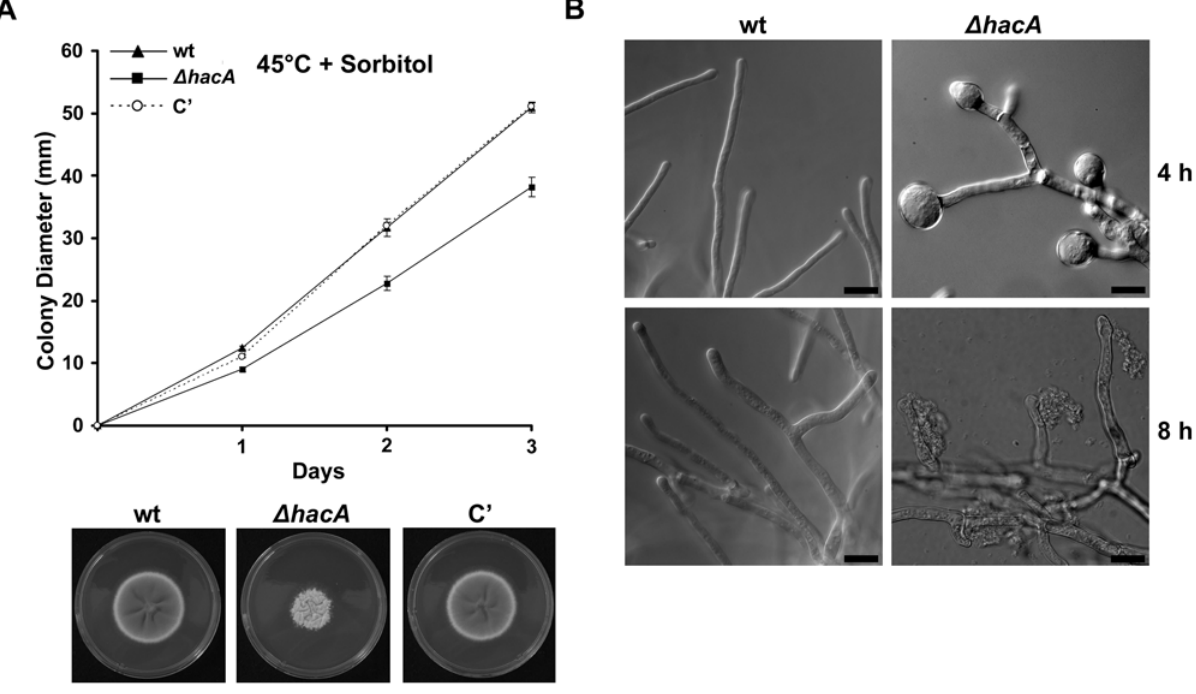
Figure 6. The UPR contributes to cell wall integrity at 45 u C. (A) The temperature-sensitivity of D hacA is remediated by sorbitol: Conidia were inoculated onto the center of an IMA plate containing 1.2 M sorbitol and incubated at 45 u C for 3 days. The experiment was performed in triplicate and colony diameter was measured daily. Values represent the mean 6 SD. Colony morphology after 3 days of incubation at 45 u C is shown in the photograph below. (B) Loss of cell wall integrity at 45 u C: wild type and D hacA conidia were inoculated onto coverslips in liquid AMM–glucose and incubated at 37 u C for 24 h. The plates were then shifted to 45 u C and the hyphae were photographed after 4 and 8 h by DIC microscopy. Experiments in Figure 6 were performed twice with similar results. Scale bar represents 30 m